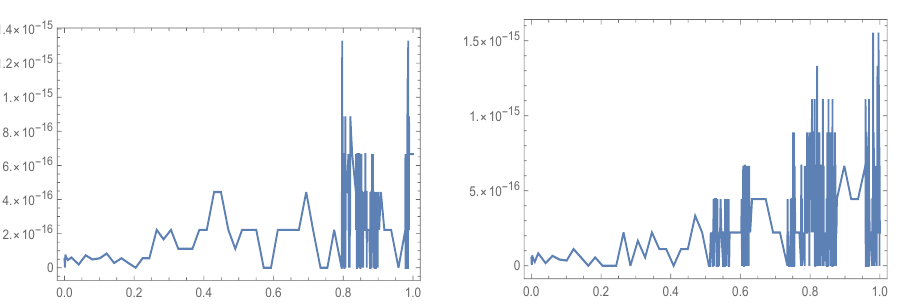
Figure 7. Log 10 ( L ∞ − errors ) and Log 10 ( L 2 − errors ) of our algorithm at υ 1 = 0.5 and N = 15 with distinct b for Example 3.